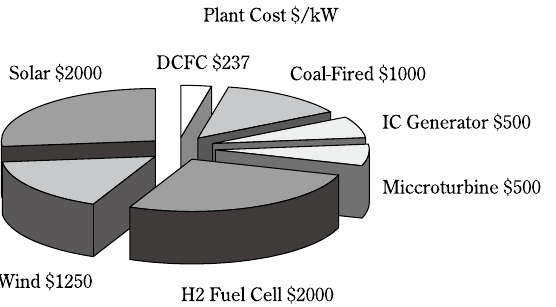
Fig. 6 EPRI Capital Cost Comparison Fig. 7 Outlet CO evolution rates from VC and TiC anodes as function of current